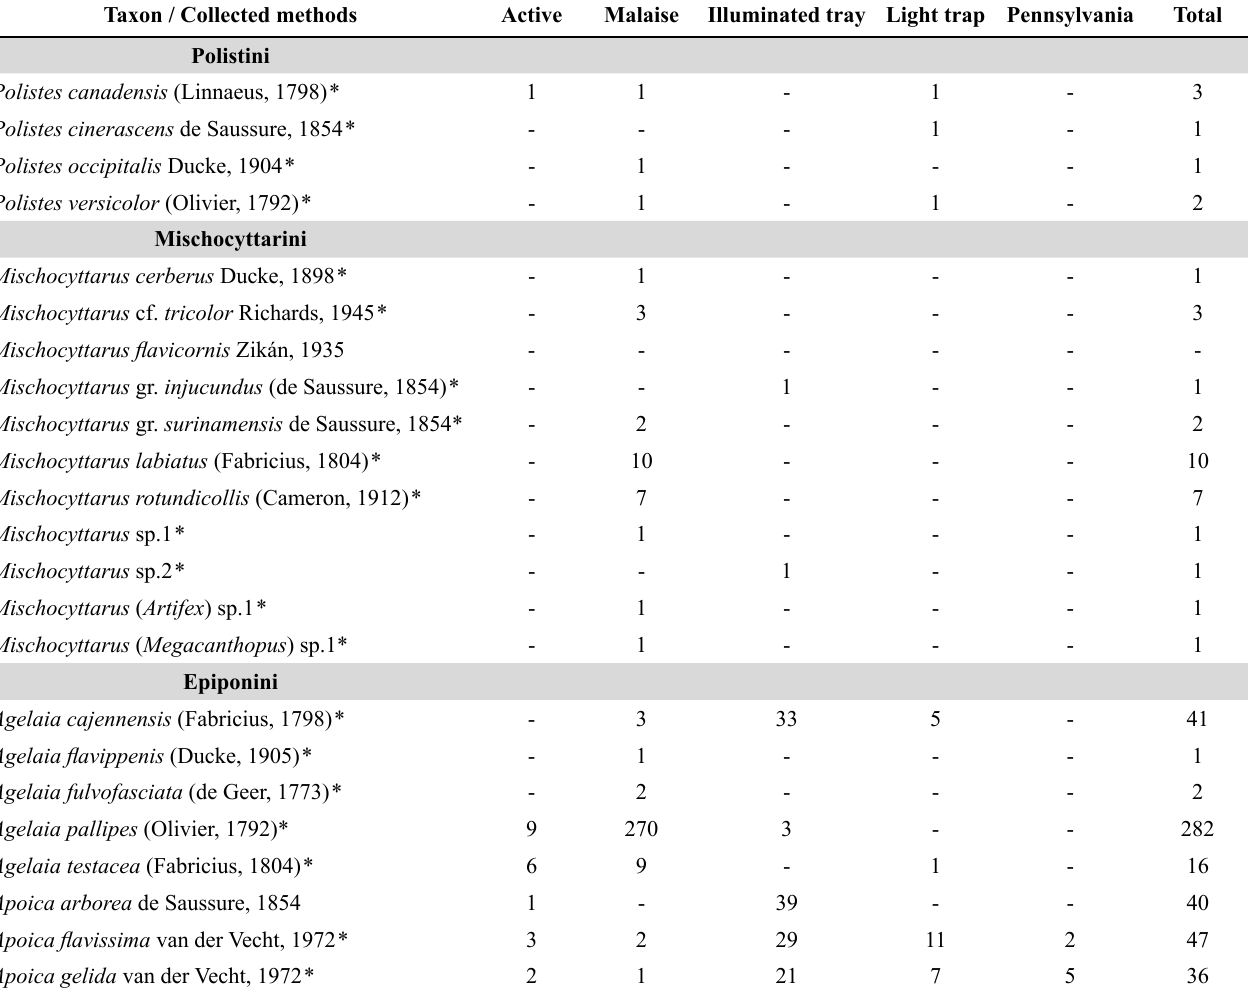
Table 1 . Species of social wasps (Vespidae: Polistinae) from the Tocantins state. Relationship between the wasp species recorded herein and the number of specimens collected in each sampling method. Fields with “-” mean that the particular species was not collected by the respective collection method. Species marked with “*” represent new records for the state of theTocantins. The species marked with “**” represents a new record for